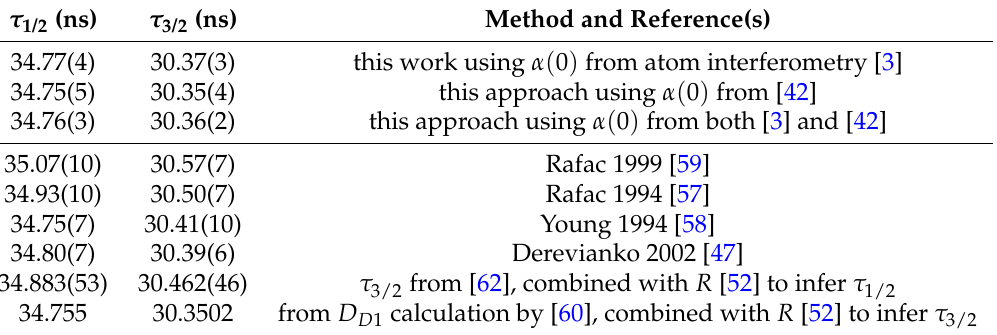
Table 3. Cesium 6 p J lifetimes ( τ J ) from several references, tabulated here for comparison. The τ 2/1 and τ 3/2 values that we report using α ( 0 ) measured by atom interferometry et al. [3] (combined with values of α r ( 0 ) [60] and R [52]) are reproduced from Table 2. Similar comparisons appear in Table II of [42] and Table I of